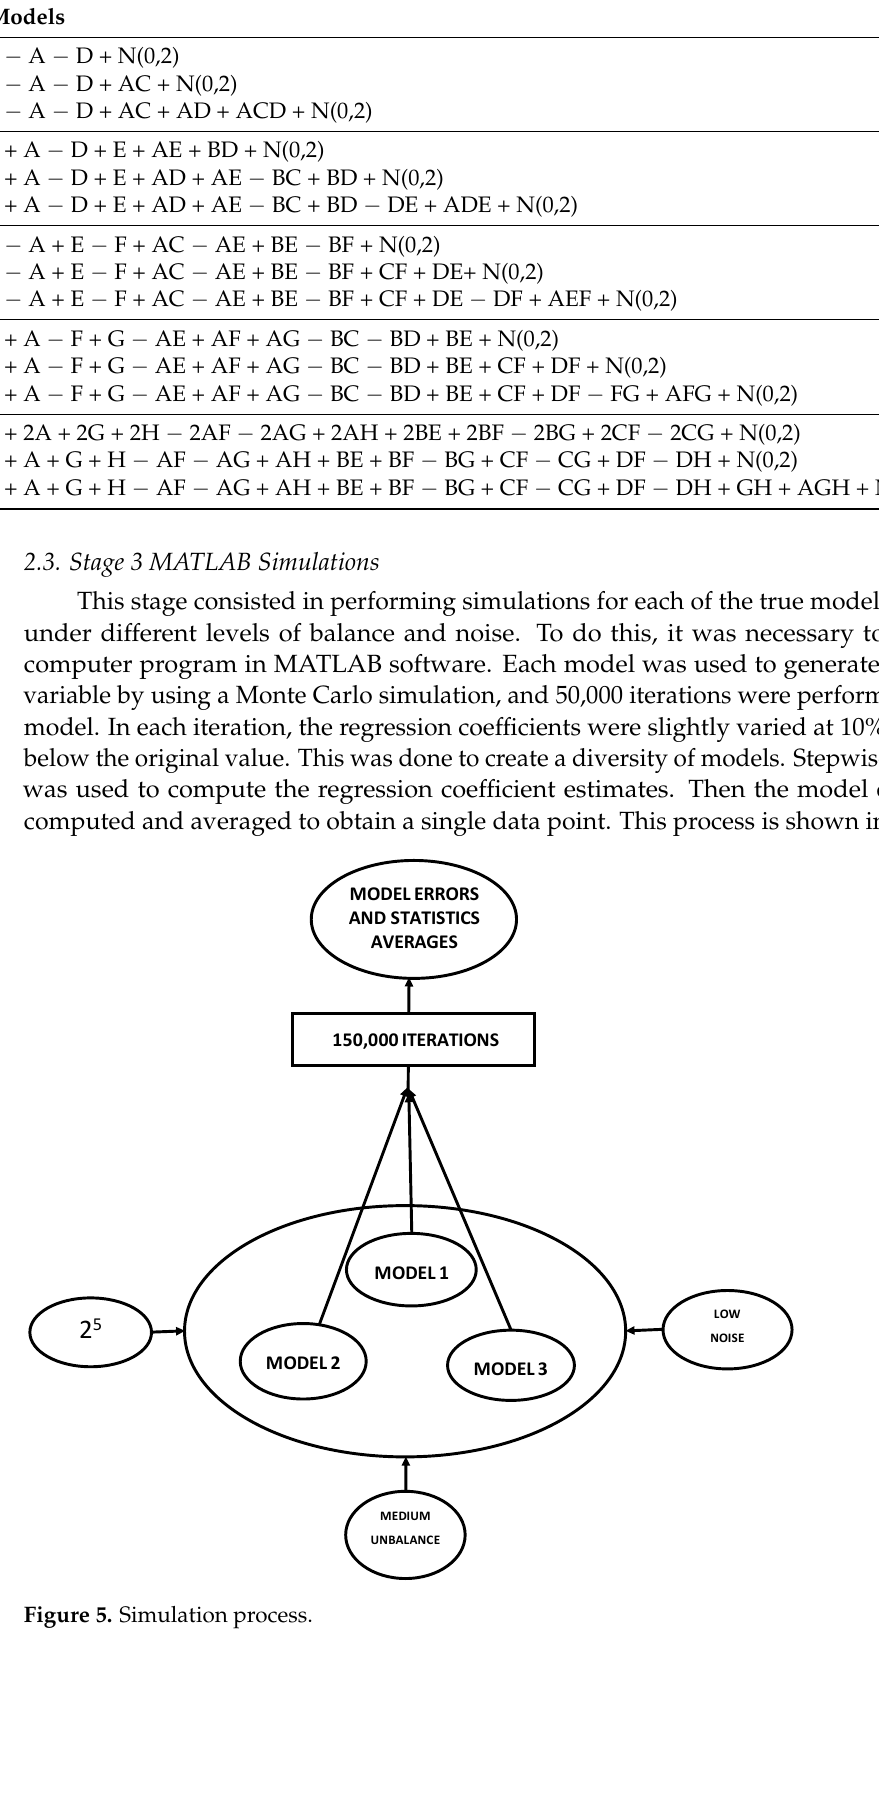
Table 6. True models with very high noise.